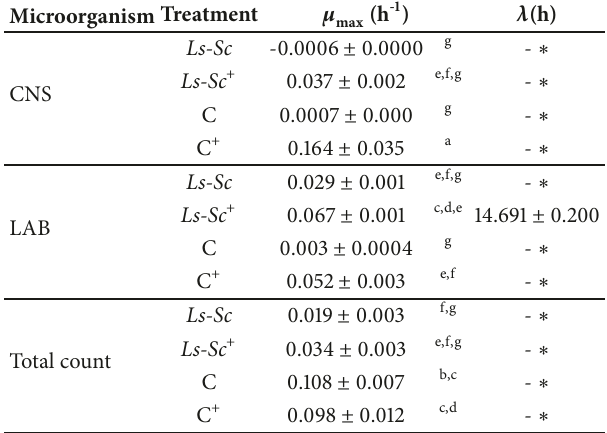
Table 5: Biokinetic parameter estimation using Baranyi and Roberts’s model.